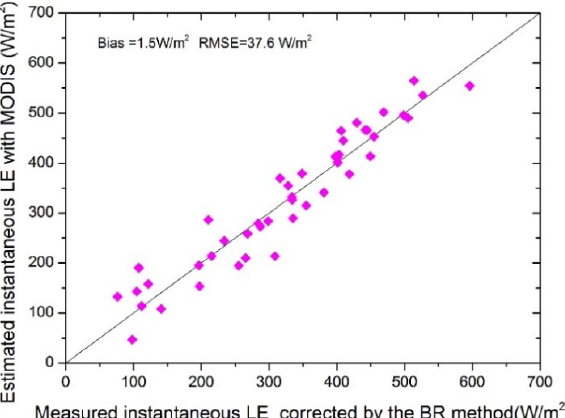
Figure 6. Validation of instantaneous ET estimations based on MODIS data, with the ET measure- ments corrected by the BR scheme.